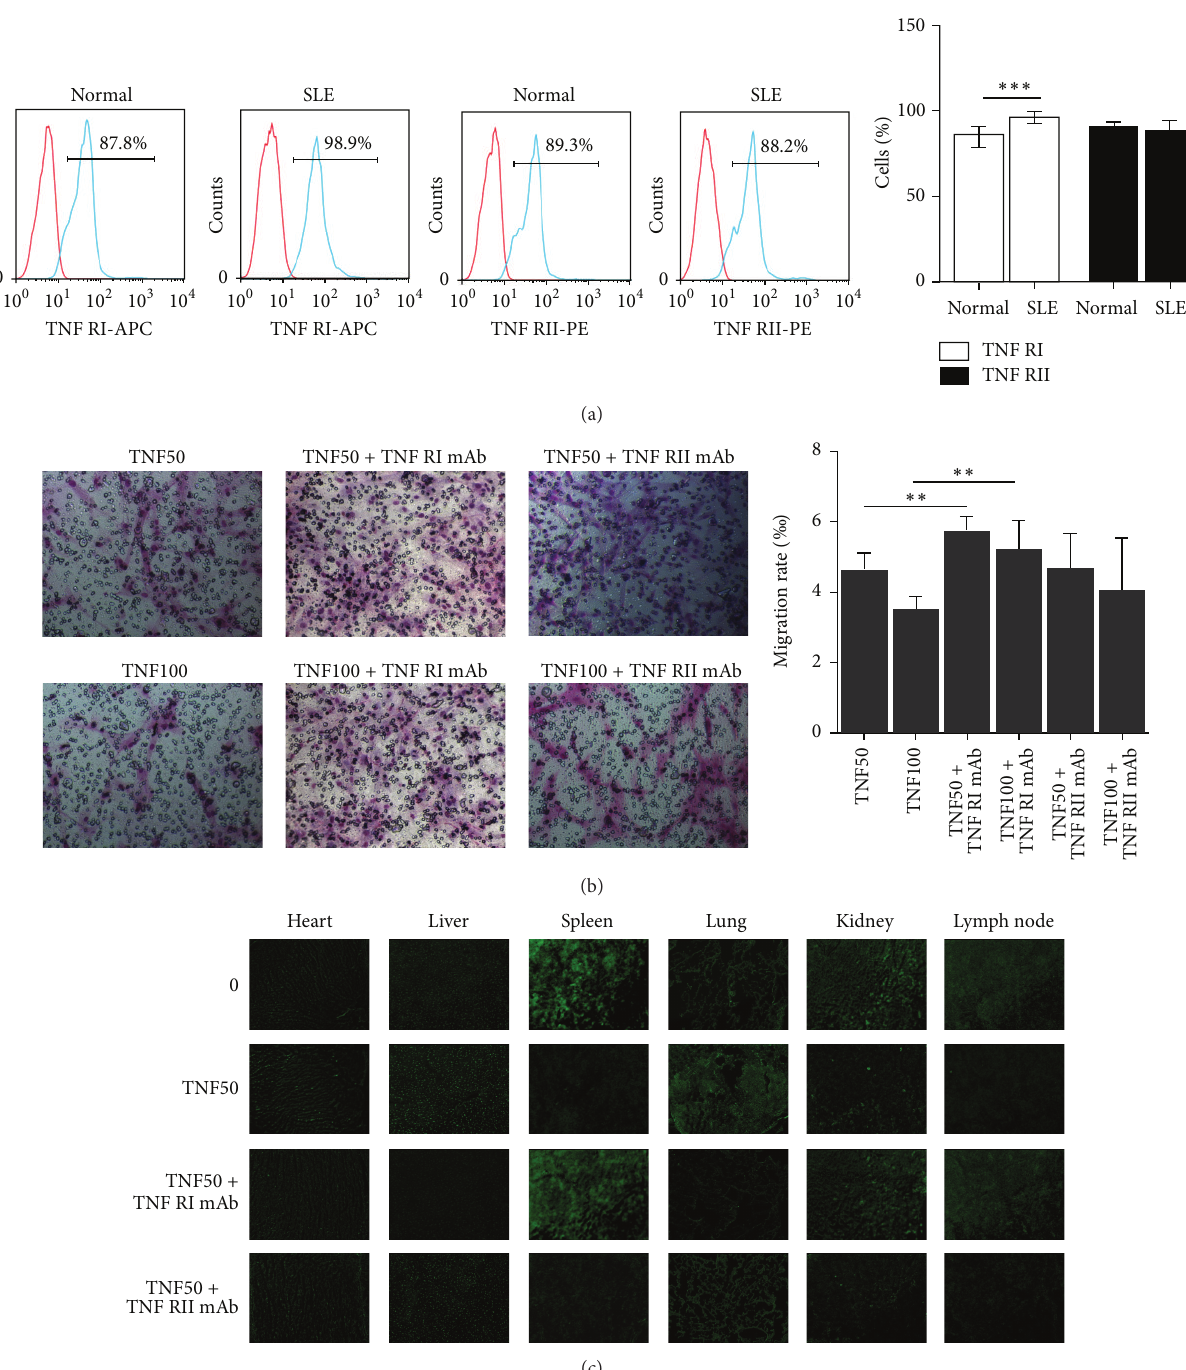
Figure 3: TNF- 𝛼 decreased migration and in vivo homing capacity of SLE BMSCs via TNFRI. (a) TNFRI percentage was increased in SLE BMSCs ( 𝑛 = 4 ). (b) Ablation of TNFRI significantly converted TNF- 𝛼 induced impaired migration capacity SLE BMSCs. (c) Compared with PBStreatedSLEBMSCsgroup, invivo homingcapacityofTNF- 𝛼 (50 𝜇 g/L)pretreatedSLEBMSCswasmarkedlyimpaired,andpreincubation of BMSCs with TNF- 𝛼 together with TNFRI mAb instead of TNFRII mAb converted SLE BMSCs homing capacity with more SLE BMSCs homing for kidney, lymph node, and spleen. TNF50: TNF- 𝛼 : 50 𝜇 g/L; TNF100: TNF- 𝛼 : 100 𝜇 g/L. ∗∗ 𝑃 < 0.01 ; ∗∗∗ 𝑃 < 0.001